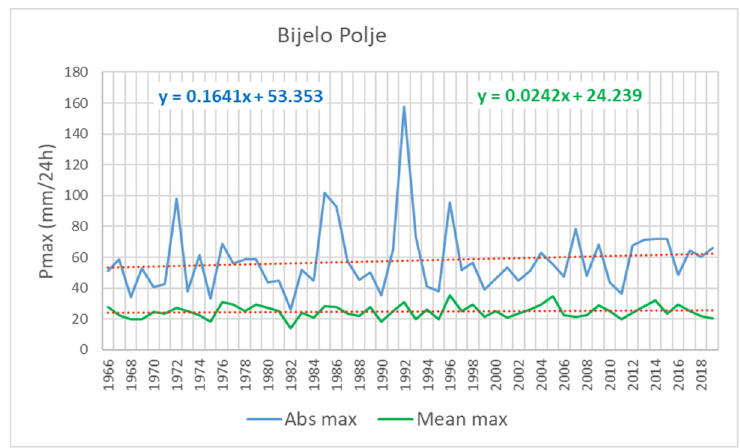
Figure 4. Long term variability of mean monthly maximum daily intensity (Mean max) and annual absolute highest daily intensity (Abs max).